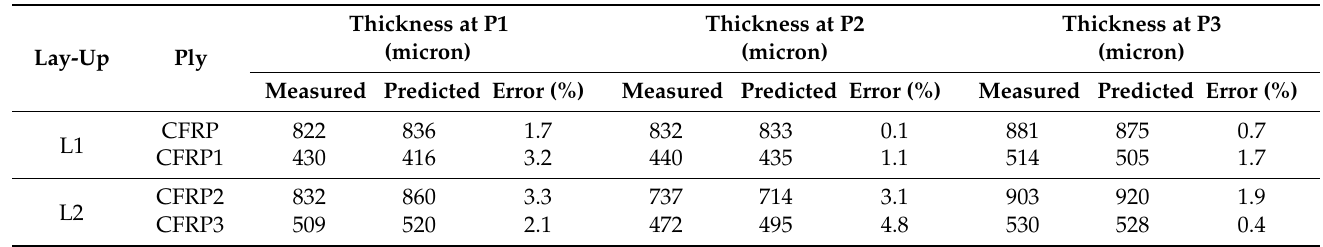
Table 7. Measured and predicted thickness of the deformed multilayered FML (temperature-dependent friction coefficient).